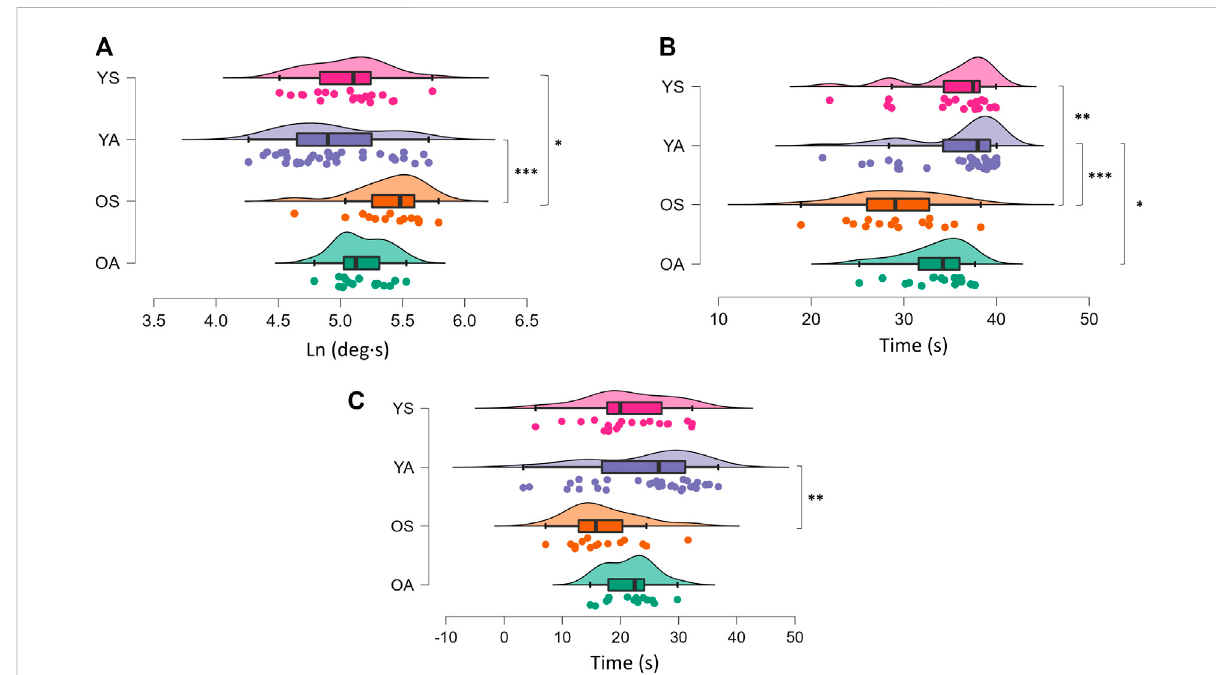
FIGURE 2 Raincloudplotofthedifferencesamonggroupsconcerningthedynamicposturalbalancecontrol.The ‘ cloud ’ illustratesdatadistribution,while the ‘ rain ’ the jittered raw data. (A) Full balance; (B) Gross balance; (C) Fine balance. * p < 0.05; ** p < 0.01; *** p < 0.001. YA: physically active young adults; YS: sedentary young adults; OA: older active adults; OS: older sedentary